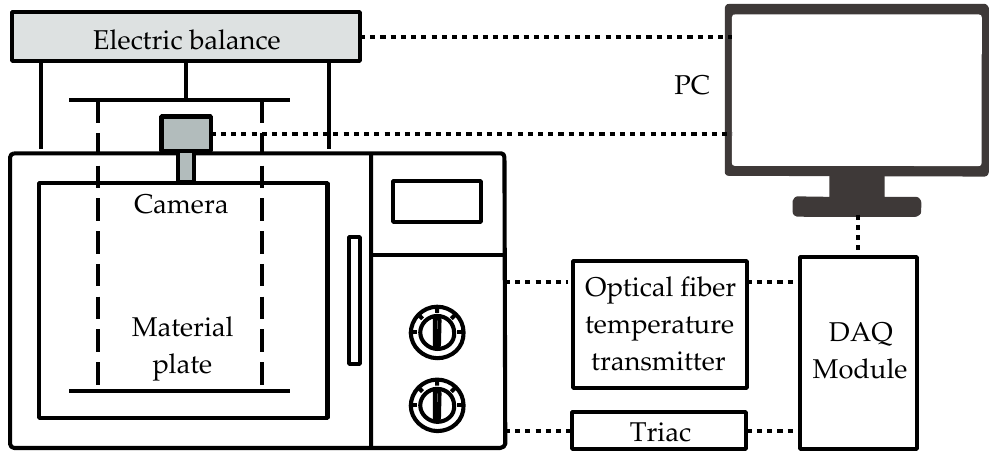
Figure 1. The schematic of the